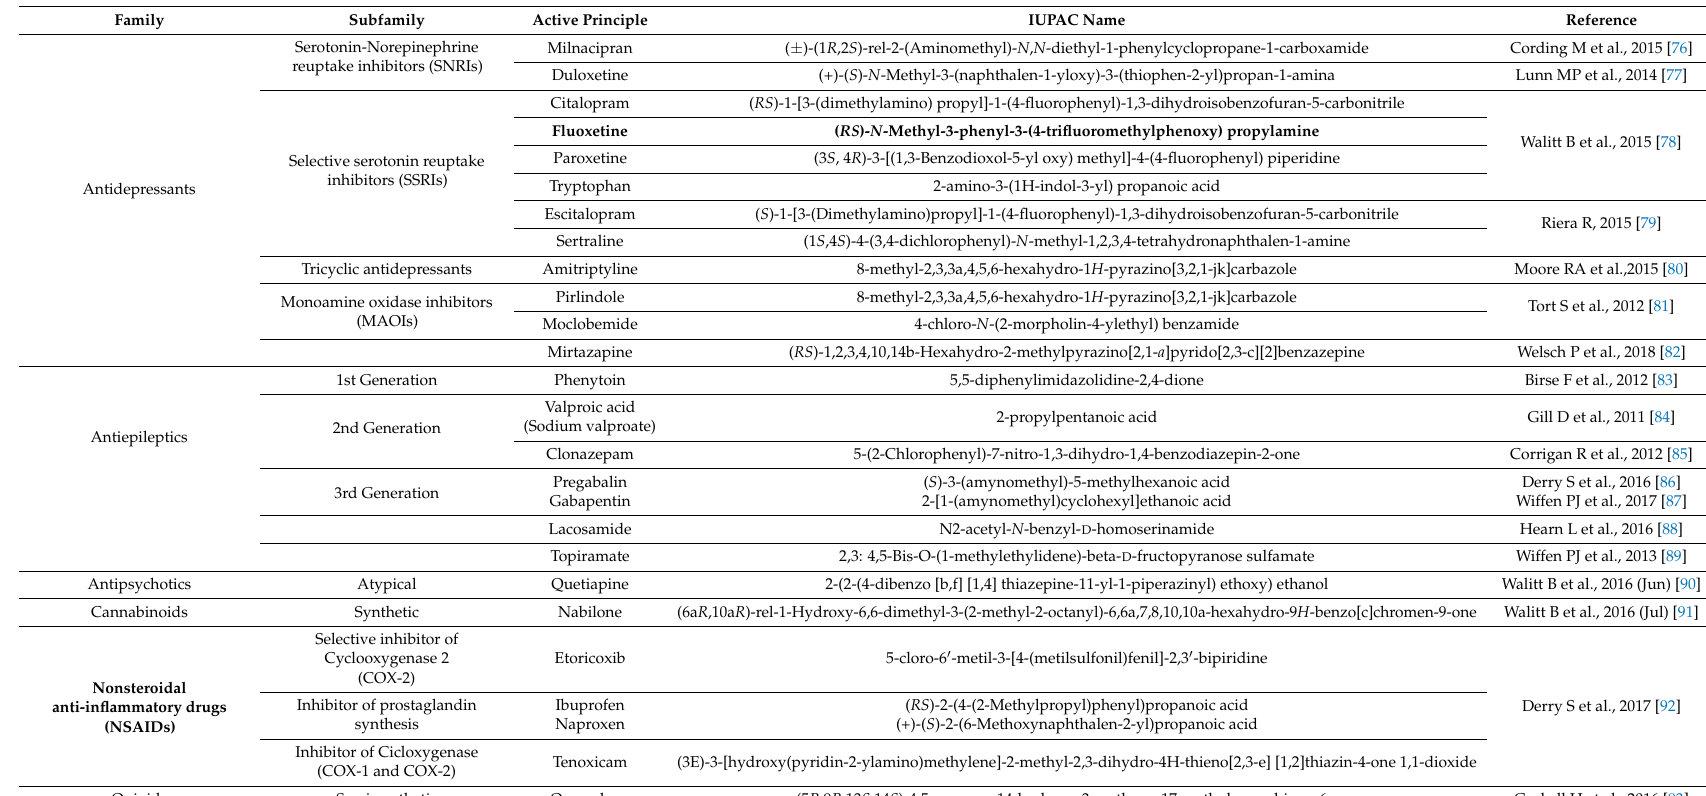
Table 3. Classification of drugs commonly prescribed to FM